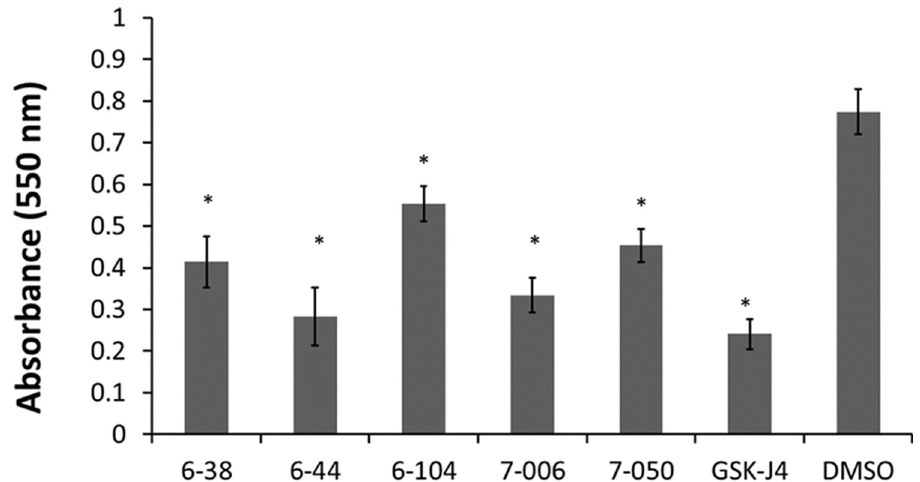
Fig 2. Effects of GSK-J4 and demethylase analogs on adult B. malayi viability. Female adult worms were cultured with 0.1% DMSO or 1 μ M of compounds 6–38, 6–44, 6–104, 7–006, or GSK-J4 for 48 hours before evaluation by MTT assay. At least seven worms were used in each treatment group. Bars represent mean absorbance and error bars show SEM. Statistical significance was determined by ANOVA and post-hoc pairwise t-tests and are indicated by asterisks if p < 0.0083 (Bonferroni correction).